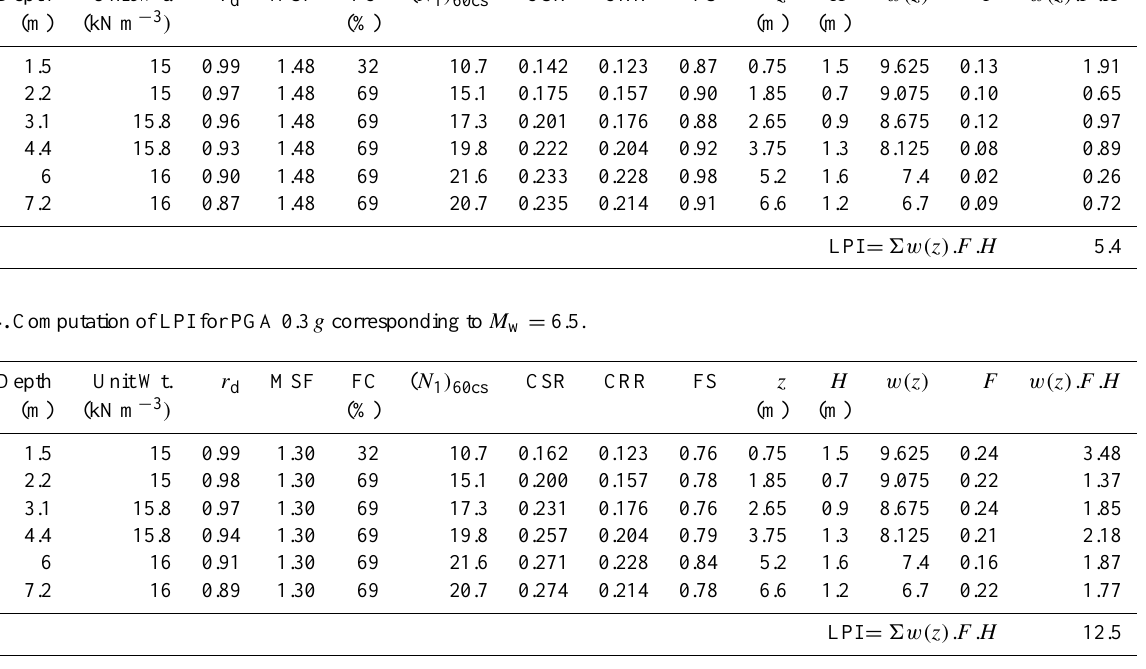
Table 3. Computation of LPI for PGA 0.3 g corresponding to M w = 6.0. Depth